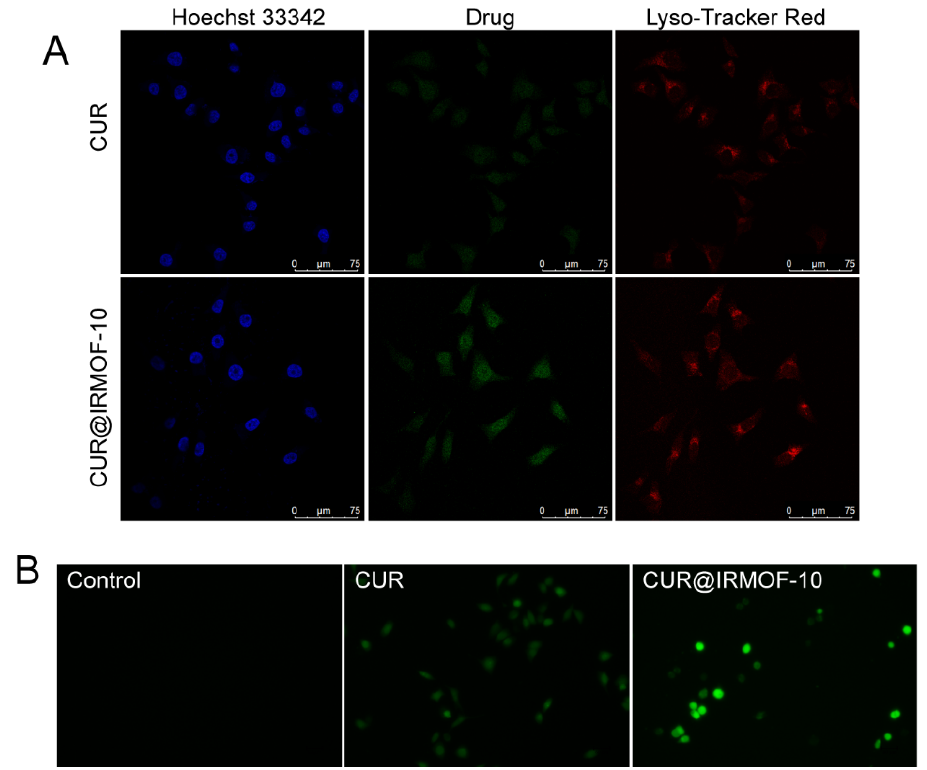
Figure 11. Cell uptake and ROS content determination: ( A ) confocal microscopy images of HepG2 cells after incubation with CUR for 30 min; ( B ) effect of CUR or CUR@IRMOF-10 on endogenous reactive oxygen species (ROS) level in HepG2 cells (administered concentration calculated based on IC 50 of CUR).